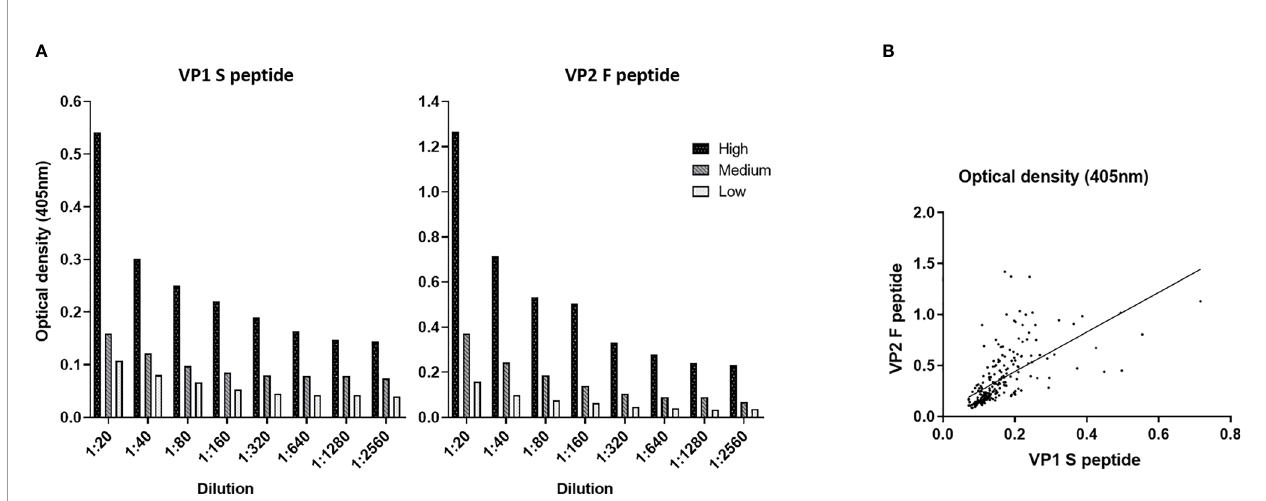
FIGURE 1 | Dilution linearity and correlation of optical density (OD) values obtained using Merkel cell polyomavirus (MCPyV) VP1 S and VP2 F peptides. (A) OD response to serial dilutions (1:20, 1:80, 1:160, 1:320, 1:640, 1:1,280, and 1:2,560) was evaluated on n = 15 MCPyV-seropositive sera with known high (n = 5), medium (n = 5), and low (n = 5) ODs. Each dilution was assayed in triplicate for each MCPyV VP1 S and VP2 F peptide; and OD values and sera dilutions were compared by linear regression analysis. High correlation between ODs and dilutions was found for VP1 S peptide with an R 2 of 0.9786 (p < 0.0001), 0.9959 (p < 0.0001), and 0.9768 (p < 0.0001) for samples with high, medium, and low ODs, respectively. Good correlation between ODs and dilutions was found when VP2 F peptide was employed, with an R 2 of 0.9773 (p < 0.0001) for sample with known high ODs, 0.9784 (p < 0.0001) for samples with medium ODs, and 0.9846 (p < 0.0001) for samples with low ODs. (B) The concordance in ODs between the VP1 S and VP2 F peptides was evaluated on the entire set of sera from elderly subjects (ES) (n = 226) using Spearman ’ s correlation analysis. A good correlation between S peptide and F peptide was found, with an r of 0.7991 and a p <